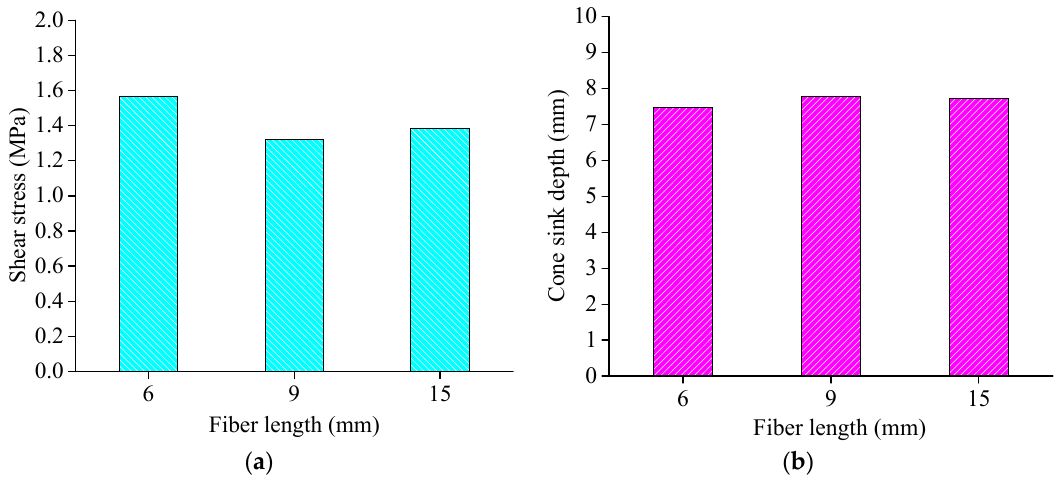
Figure 13. Shear stress and cone sink depth for fiber-reinforced asphalt binder with different fiber lengths: ( a ) Shear stress; ( b ) Cone sink depth. The testing temperature was set to 25 °C.